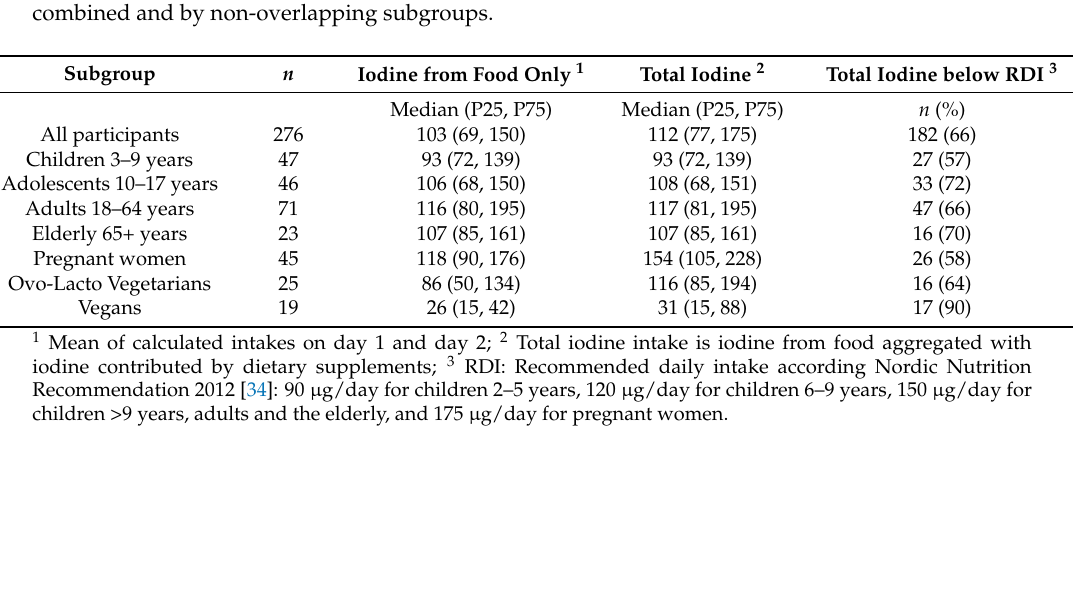
Table 3. Calculated daily iodine intake ( µ g/day) from two-day food records in all participants combined and by non-overlapping